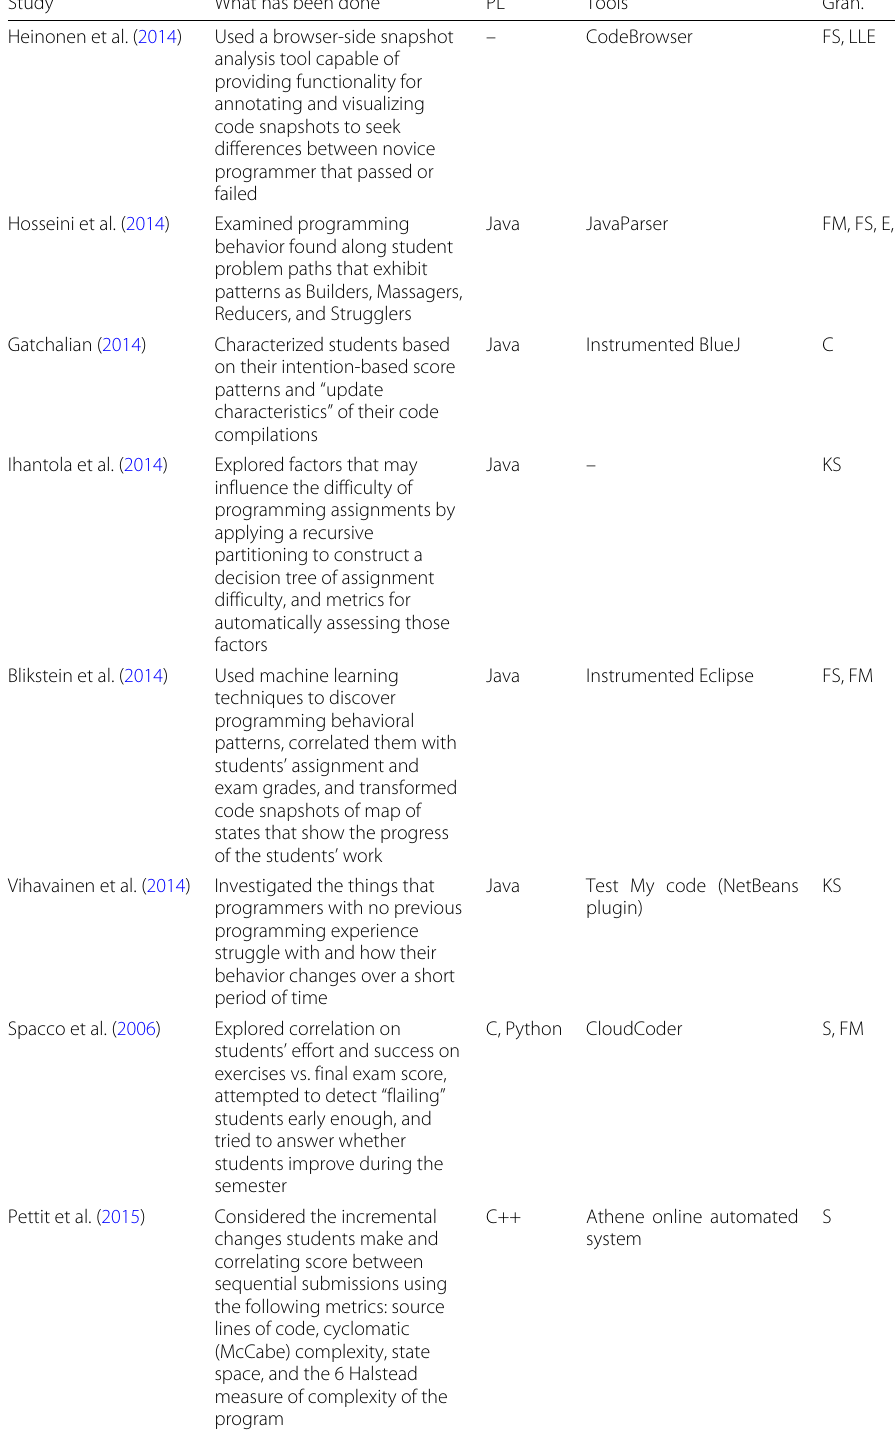
Table 1 Studies conducted using a process-oriented approach in the context of novice programming ( Continued